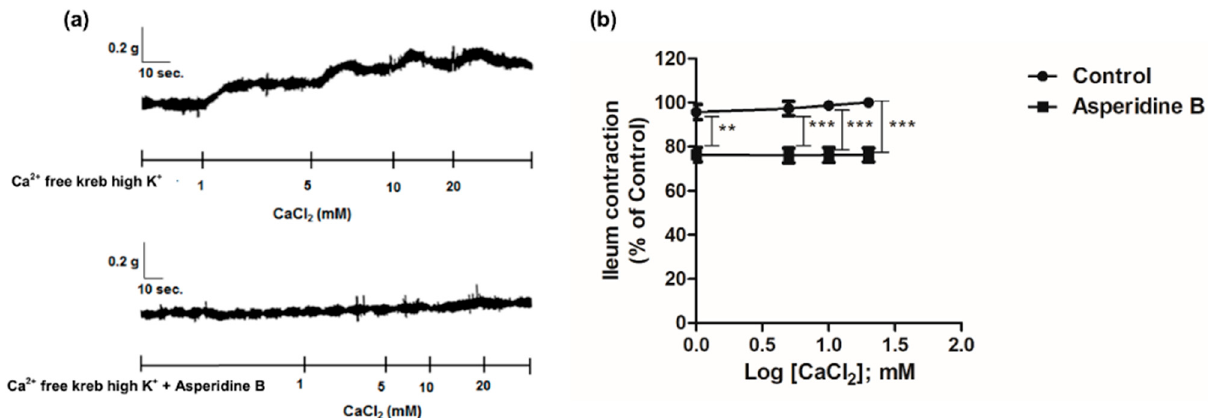
Figure 2. ( a ) Tracing and ( b ) activity of the contractile response of rat’s ileum smooth muscle to a cumulative concentration of CaCl 2 in the absence or in presence of asperidine B ( n = 6). *** p < 0.001; ** p < 0.005 versus control.